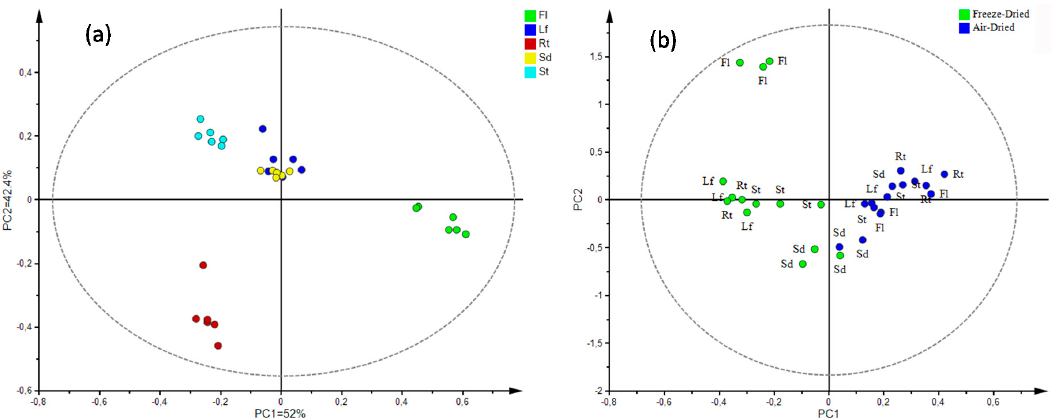
Figure 7. ( a ) Orthogonal partial least squares discriminant analysis (OPLS-DA) derived score plot for individual LC / MS samples tested, supervised by plant parts. Unit variance (UV) autoscaling. ( b ) OPLS-DA score plot for individual LC / MS samples tested, discriminated by drying process method. Internal cross-validation produced Q 2 = 0.892. UV autoscaling.